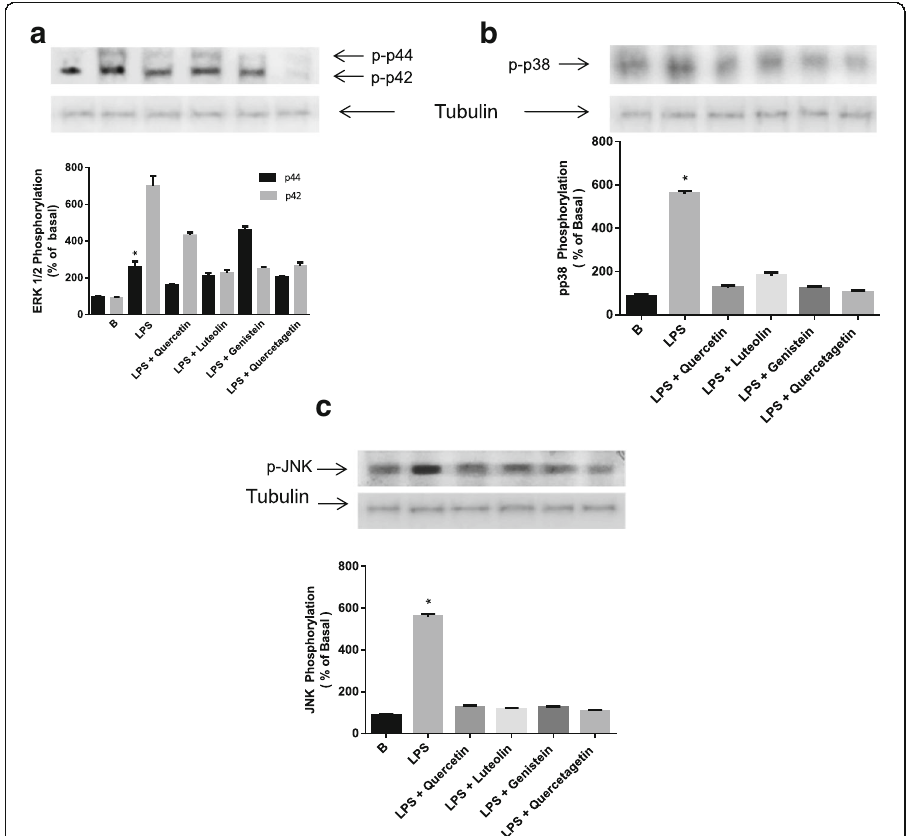
Fig. 4 The effect of LPS on ERK 1/2, p38 and JNK phosphorylation in time- and dose-dependent response. H9c2 cells were placed in 6-well plates. Cells were stimulated with LPS (1 μ g/ml) for the times and doses indicated in the figure. Cell lysates were fractionated via SDS-PAGE and analyzed via western Blotting using an antibody against phospho-ERK 1/2 ( a ), − p38 ( b ) or -JNK ( c ). Membranes were then stripped and reprobed using an antibody against each kinase as a control for equal loading. The data are representative of one of three independent experiments performed with similar results. Phosphorylation was quantified via densitometry with LabWorks 4.0 (Upland, CA, USA) commercial software. The results are expressed as means ± S.D. * p < 0.05 vs. untreated